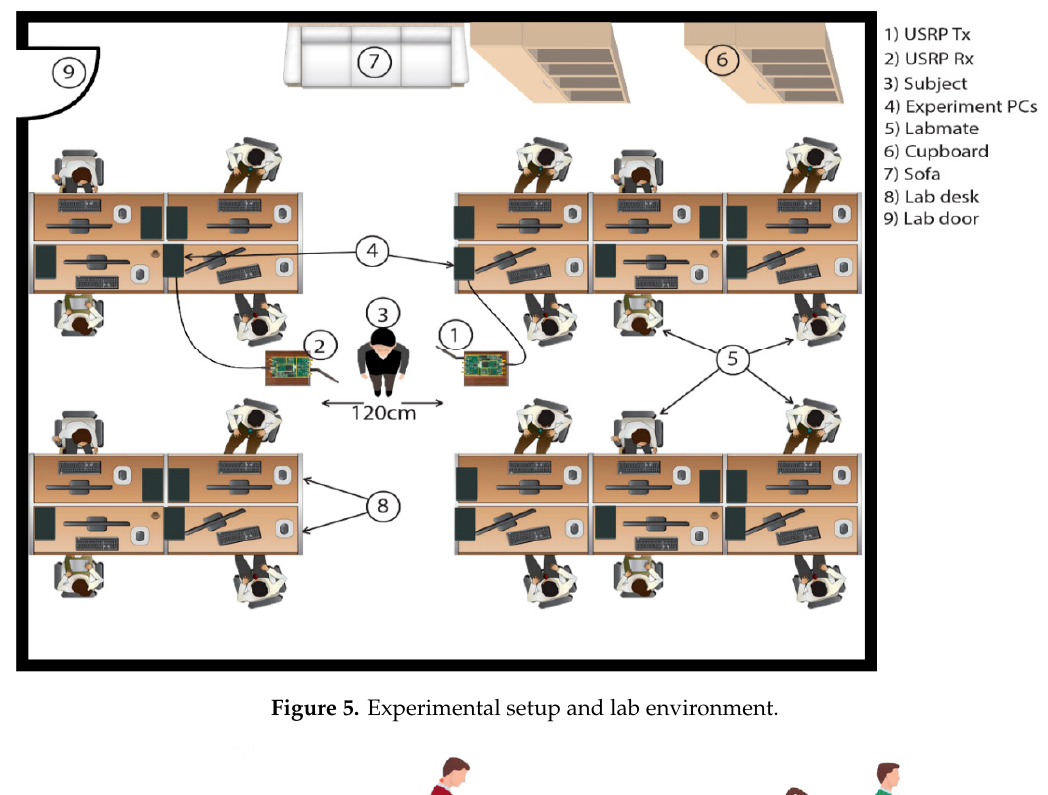
Appl. Sci. 2020 , 10 , x FOR PEER REVIEW Figure 5. Experimental setup and lab environment. Figure 5. Experimental setup and lab environment.